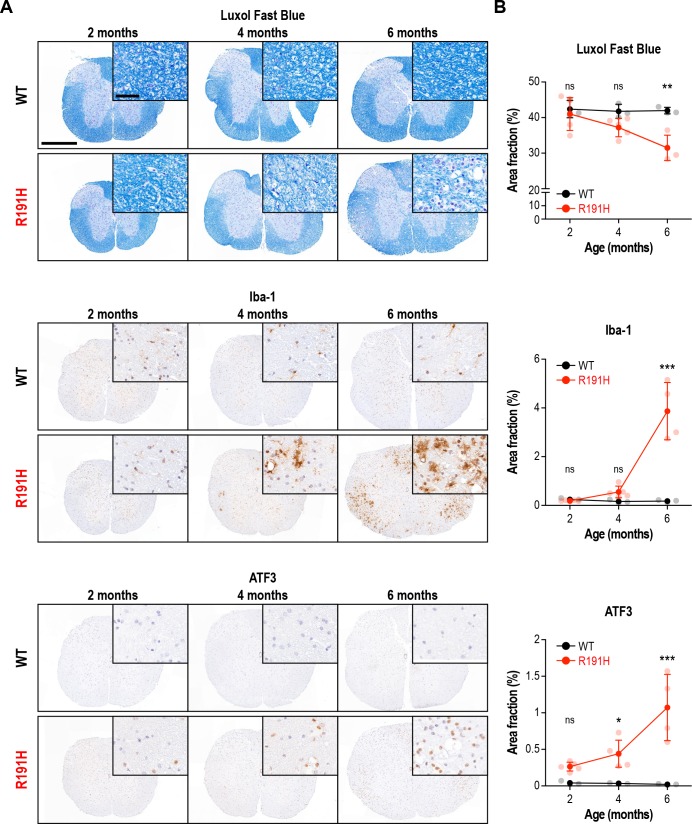
Age-dependent myelin loss and inflammation in the spinal cord of R191H mice.(A) Representative IHC images of the lower cervical/upper thoracic region of the spinal cord of female mice at 2, 4 and 6 months of age. Scale bar, 500 μm. Inset is magnified 6.8X. Inset scale bar, 50 μm. (B) Quantification of staining in (A). N = 3 (2 mo WT), 5 (2 mo R191H), 3 (4 mo WT), 5 (4 mo R191H), 3 (6 mo WT), 4 (6 mo R191H) females. Error bars are SD. *p<0.05; ***p<10-4; nsp>0.05 by 2-way ANOVA with Holm-Sidak correction.